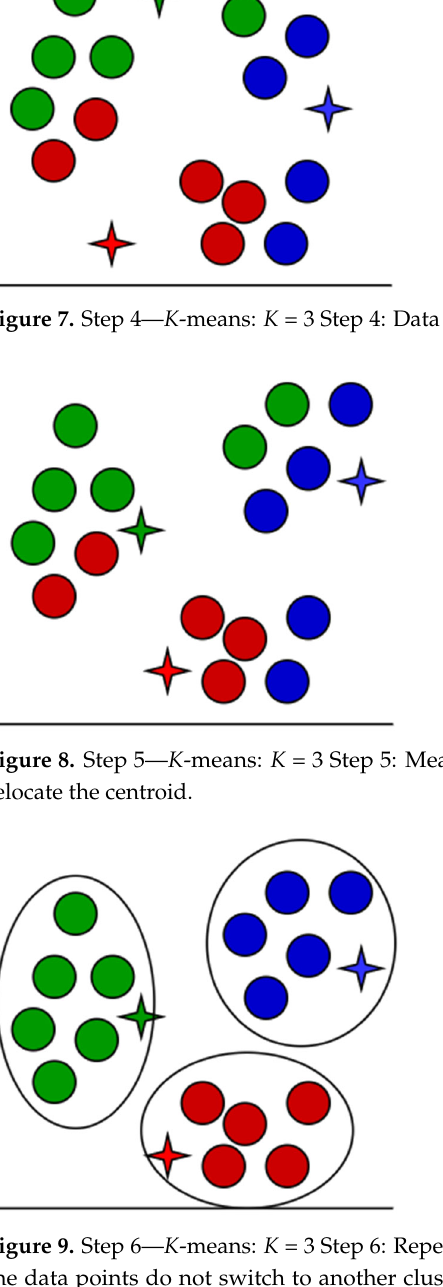
the distance from each centroid using Euclidean Distance formula: 𝑑(cid:4666)𝑥 , 𝑦(cid:4667) (cid:3404) (cid:3493)∑ (cid:4666)𝑦 (cid:3036) (cid:3398) 𝑥 (cid:3036) (cid:4667) (cid:2870)(cid:3041) (cid:3036)(cid:2880)(cid:2869) Eu ‐